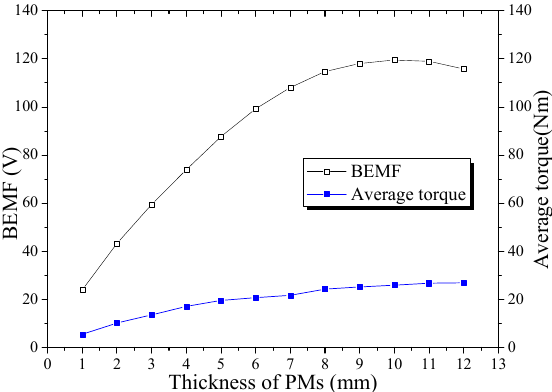
Figure 19. Variation of BEMF and average torque versus thickness of PMs.